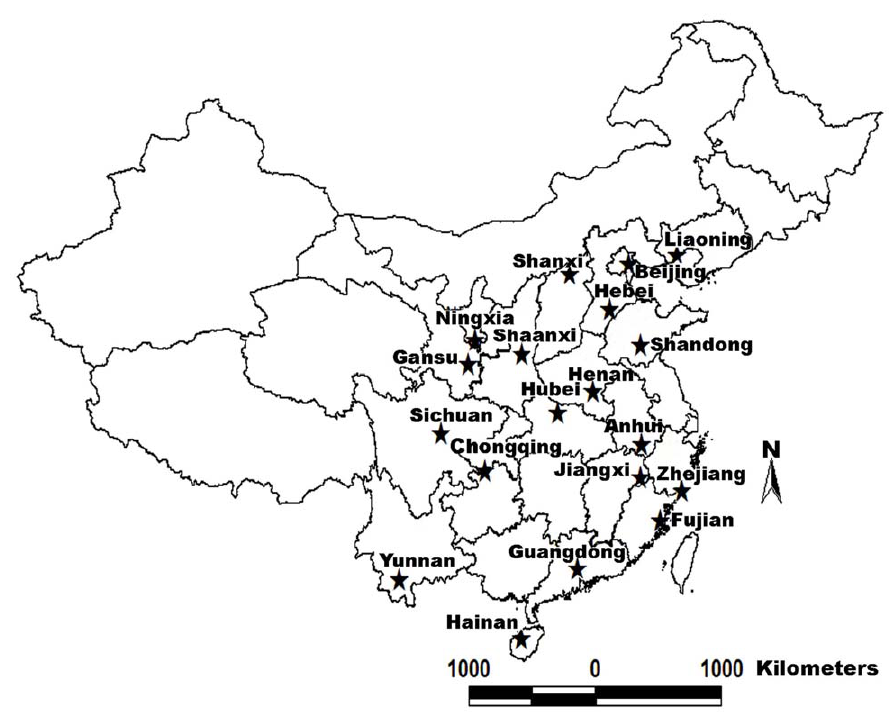
Figure 1. Sampling locations in China. See Table 2 for collection details of location.